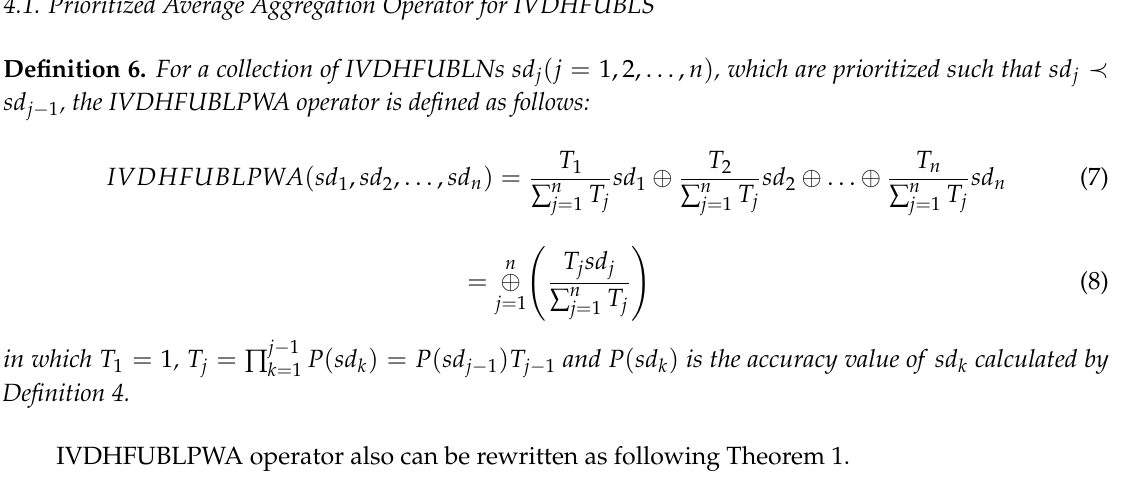
algorithm for MAGDM under IVDHFUBLS environment in which prioritization relation among evaluating attributes exists and decision-makers’ weighting vector is